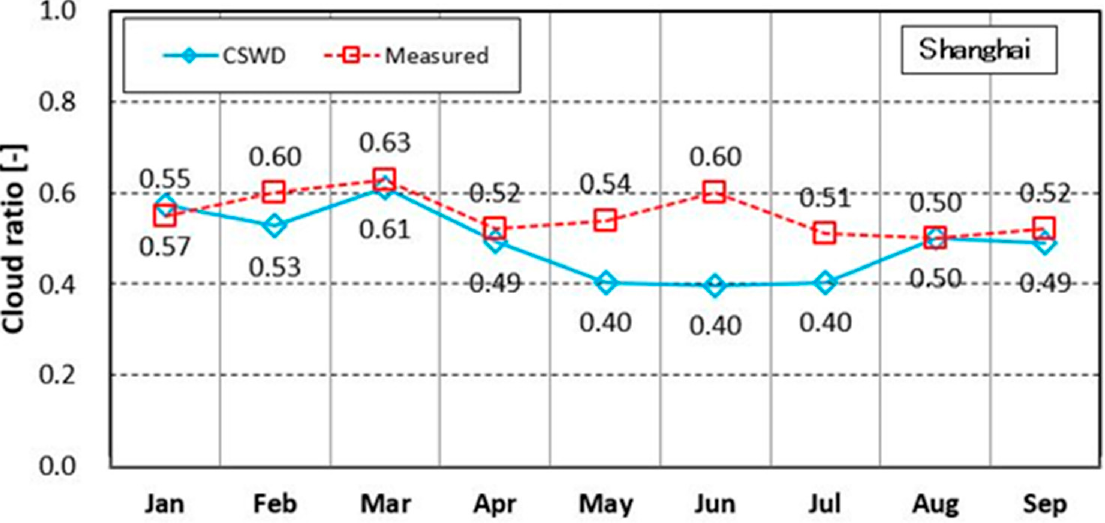
Figure 7. Monthly average cloud ratios calculated by observed solar radiation and CSWD database in Shanghai, China.